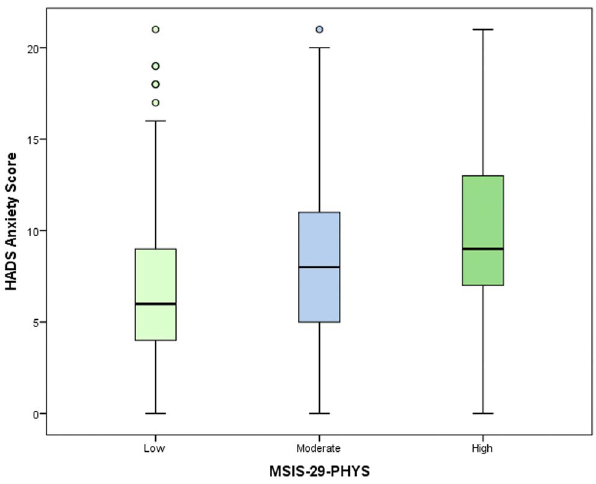
Figure 3. The variation in anxiety scores by physical disability. The variation in the median (and IQR of the) anxiety scores in relation to MSIS-29-PHYS scores divided into tertiles and categorised as low, moderate and high disability can be seen. The anxiety scores were highest for people in the high disability category and lowest in the low disability category ( p , 0.001).